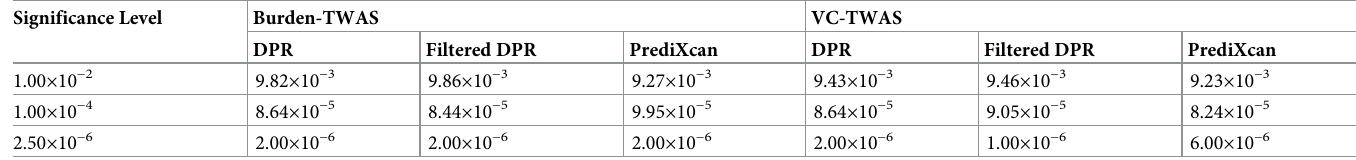
= 0.1, using variant weights given by DPR, filtered e